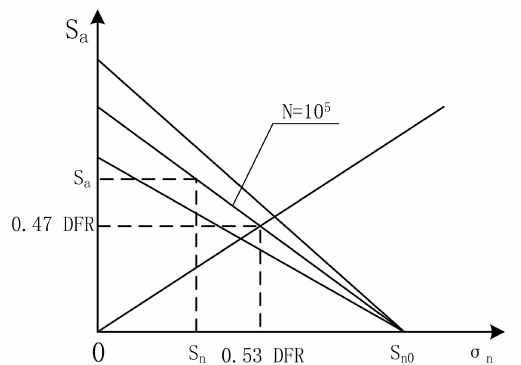
Figure 8. The equivalent fatigue life curves subject to the power